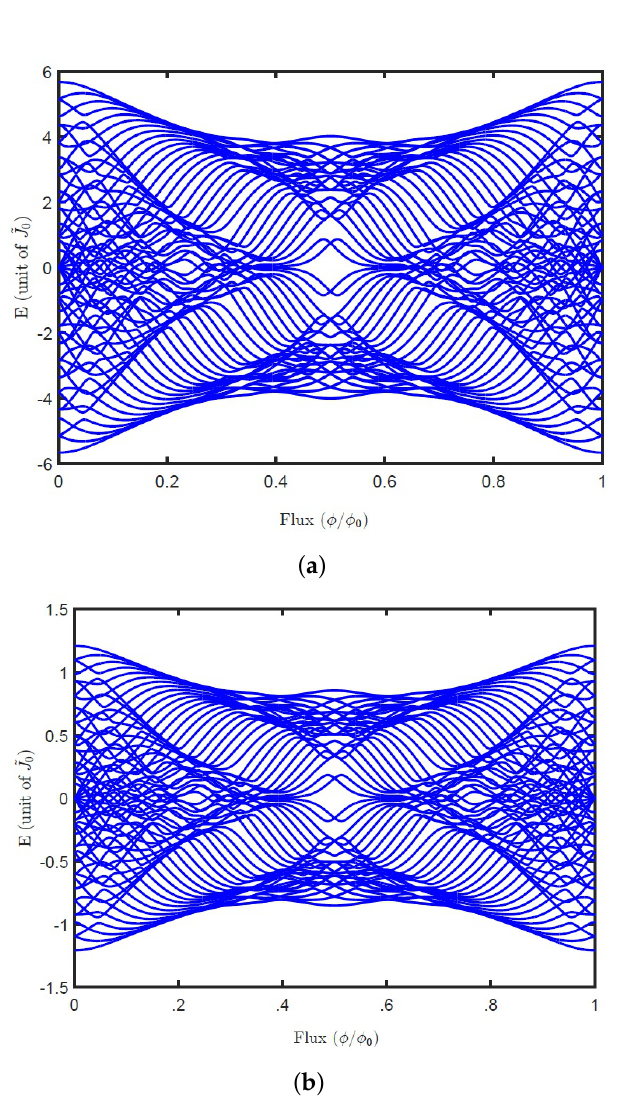
Figure 6. The spectra obtained in presence of a purely abelian gauge field, for different cavity detunings: ∆ = − 45 MHz; (b) ∆ = 45 MHz. Here we have taken a 8 × 8 lattice with a filling factor equal to